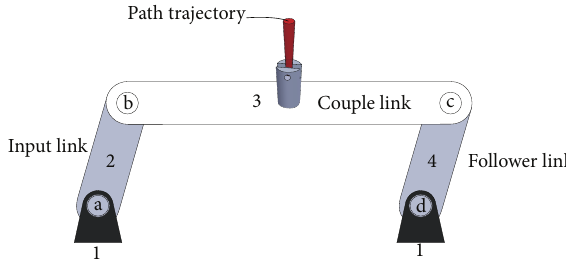
Figure 3: Four-bar